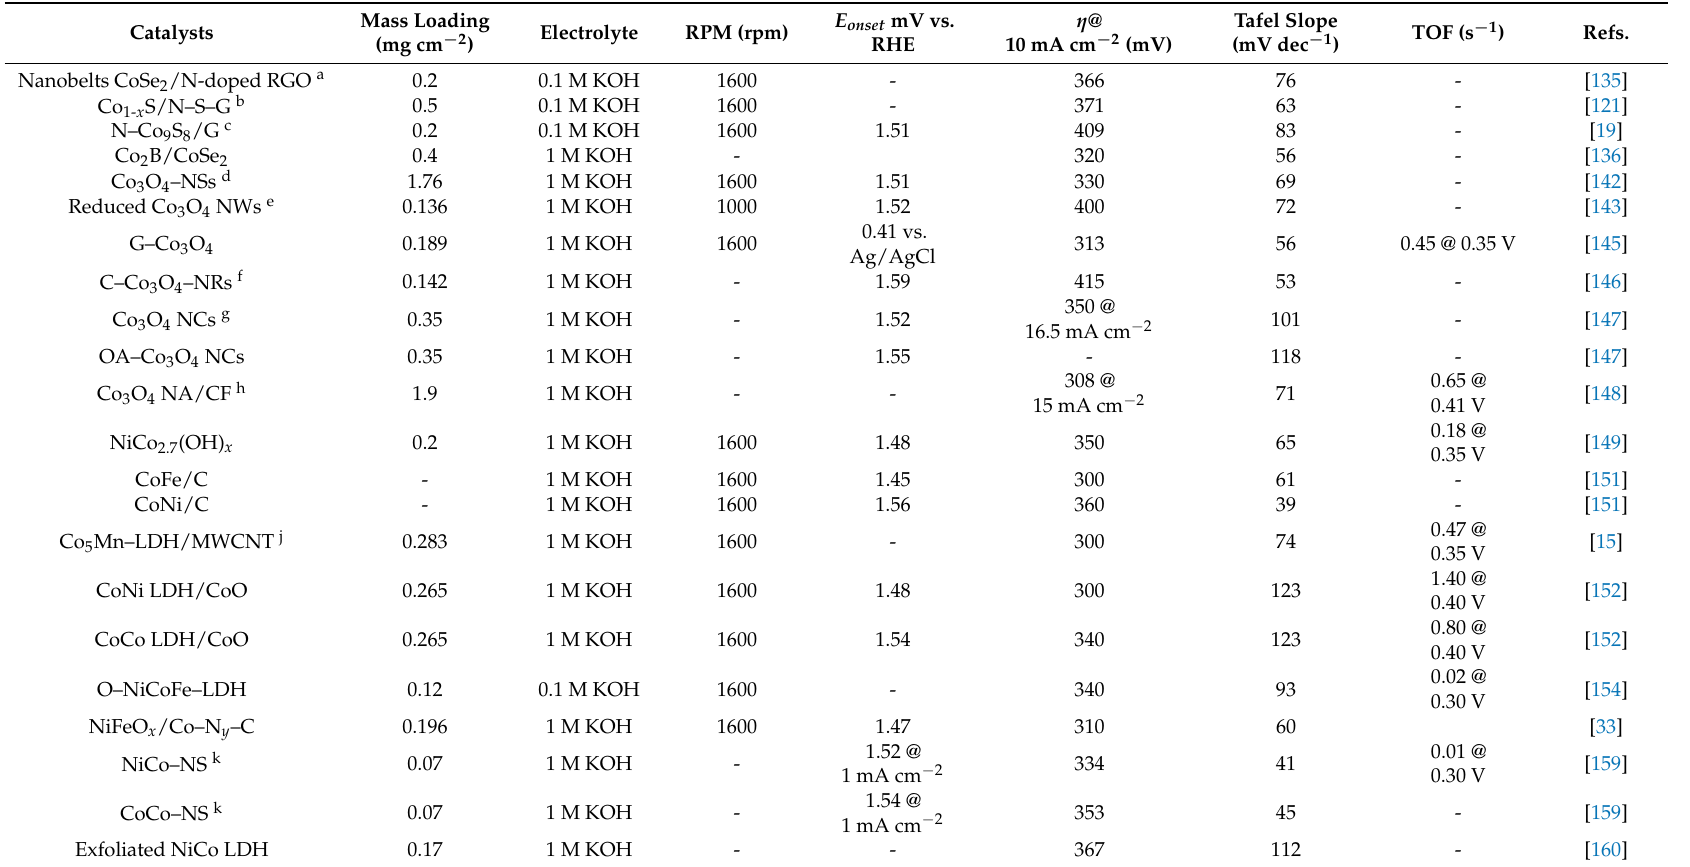
Table 2. Selected Co-based catalyst towards the oxygen evolution